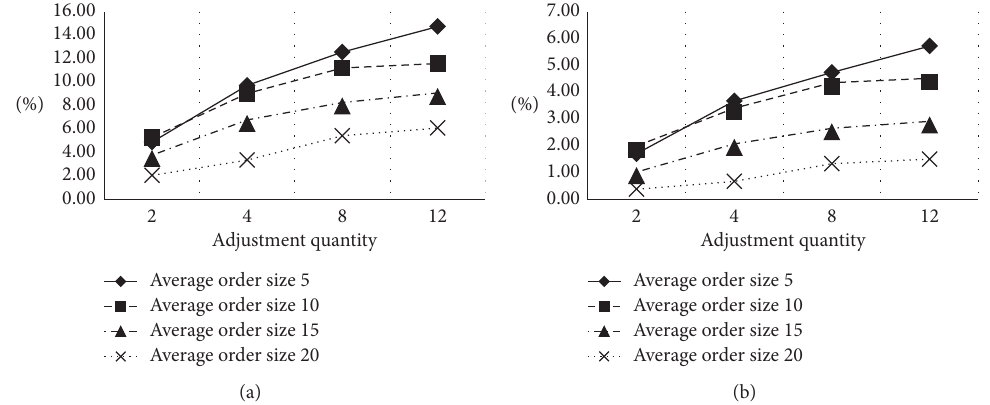
Figure 8: Co-optimization effect between adjustment quantity and average order size: (a) saving distance and (b) saving time.